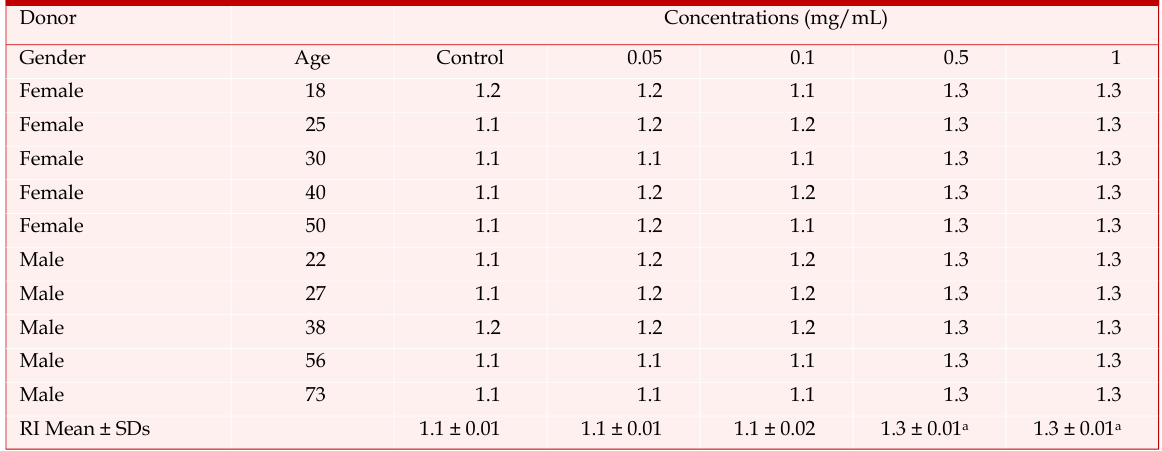
Replication index in human lymphocyte cultures exposed to extracts of Hypericum